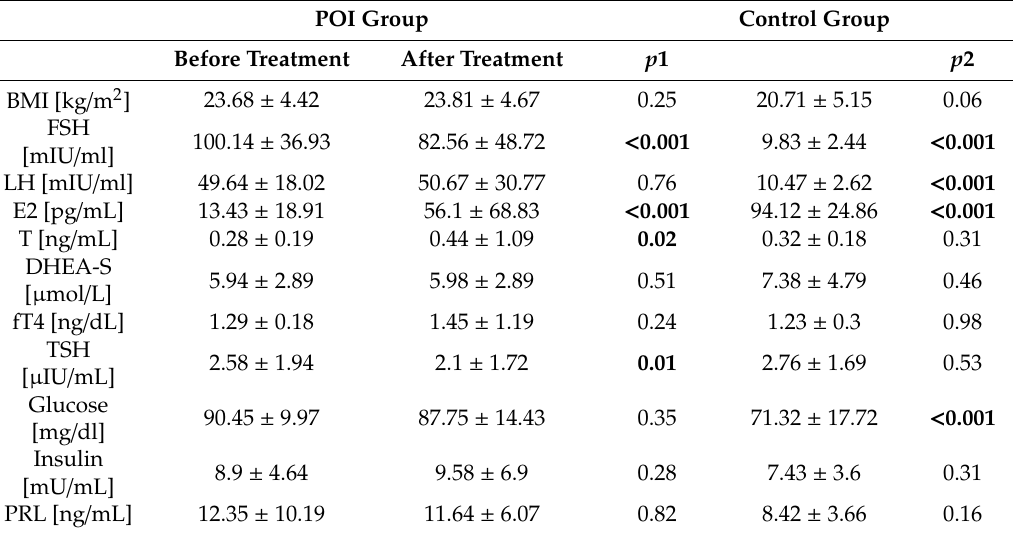
Table 1. Characterization of POI group and control group.